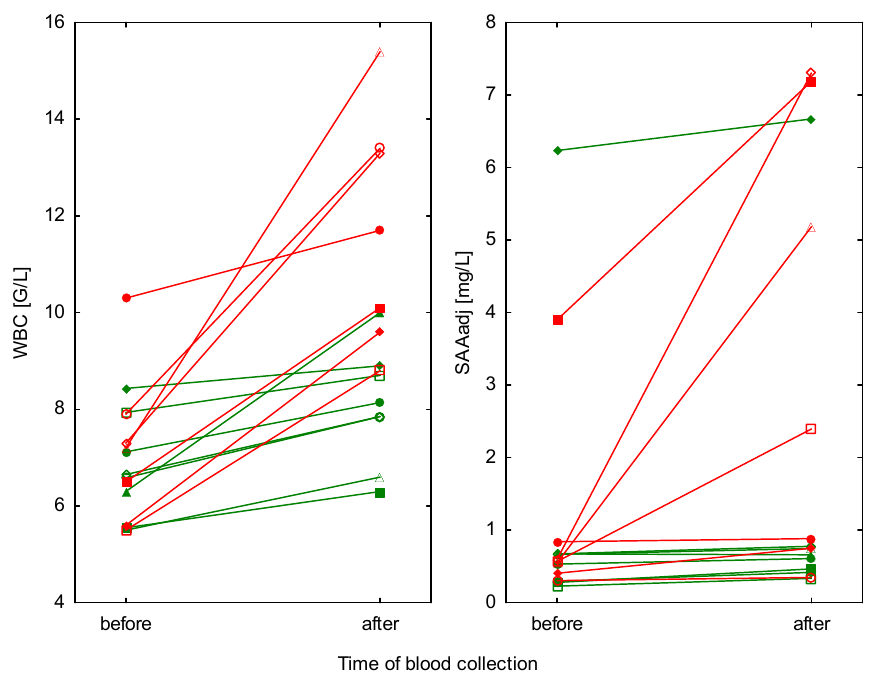
Figure 1. WBC counts and SAA concentrations before and after training sessions in eight horses (green lines) and before and after competitions in seven horses (red lines). Table 2. WBC and SAA adj before and after the effort (training and competition).